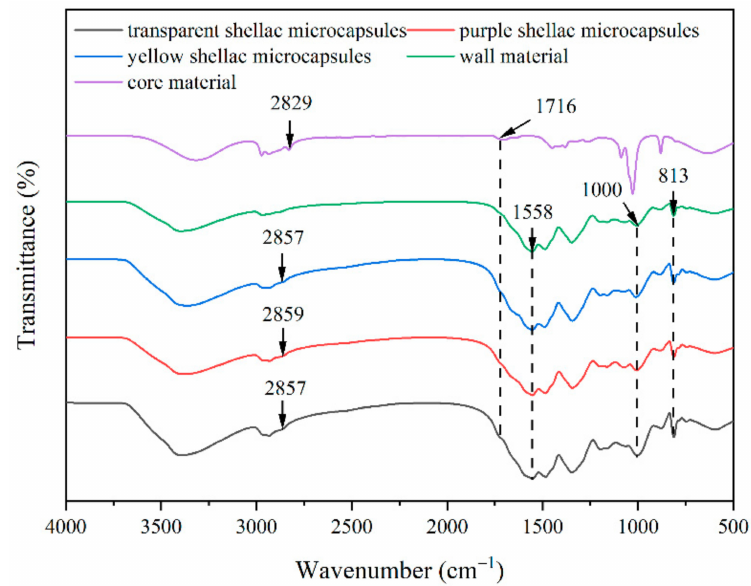
Figure 4. FTIR of core material, wall material, transparent, purple, and yellow shellac